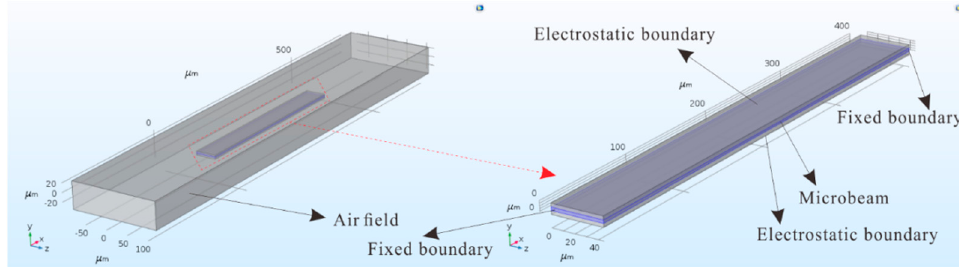
Figure 3. COMSOL simulation model.